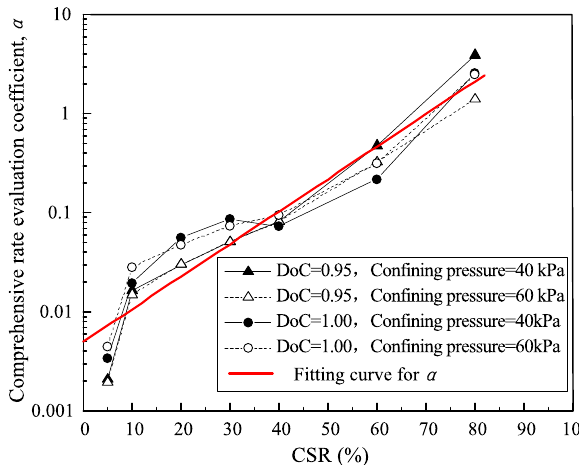
Figure 10. The relationship between comprehensive evaluation coefficient α and